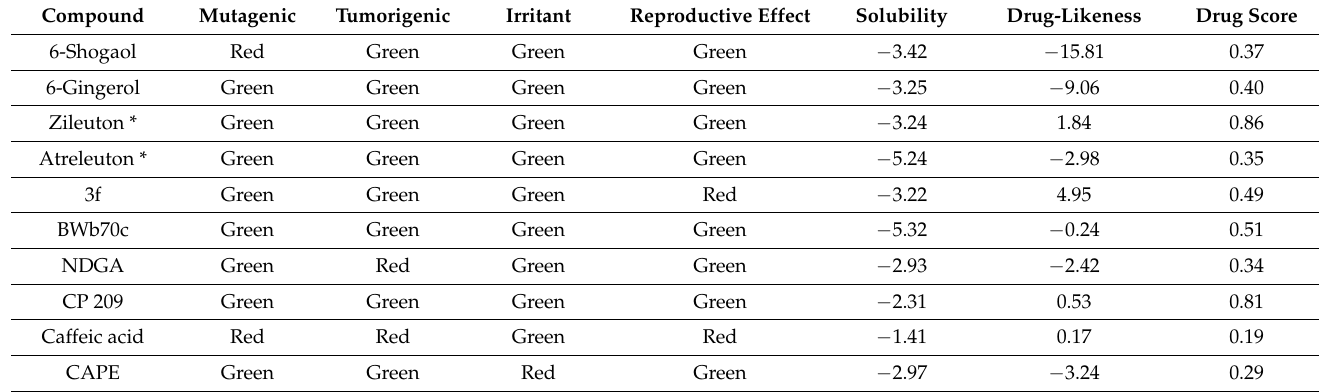
Table 2. Evaluation of drug-likeness, drug score, and toxicity risks of 6-shogaol and 6-gingerol compared to 5-LOX redox inhibitors using Osiris Data warrior